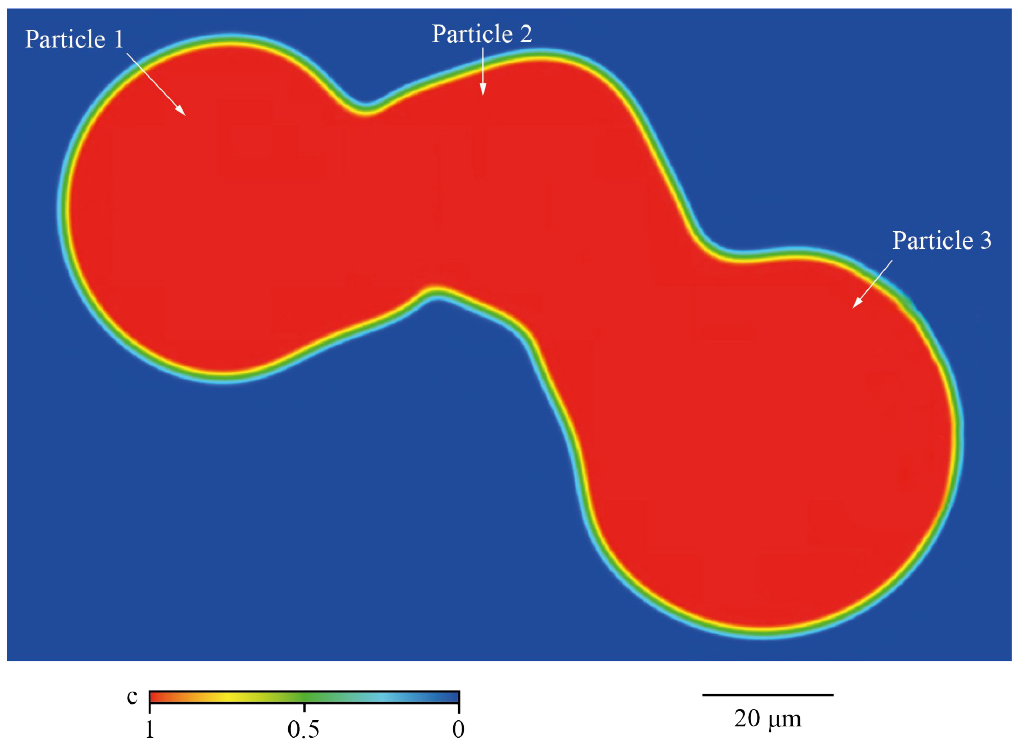
Figure 6. Powder particles distorted from an inappropriate selection of the RBM parameters.